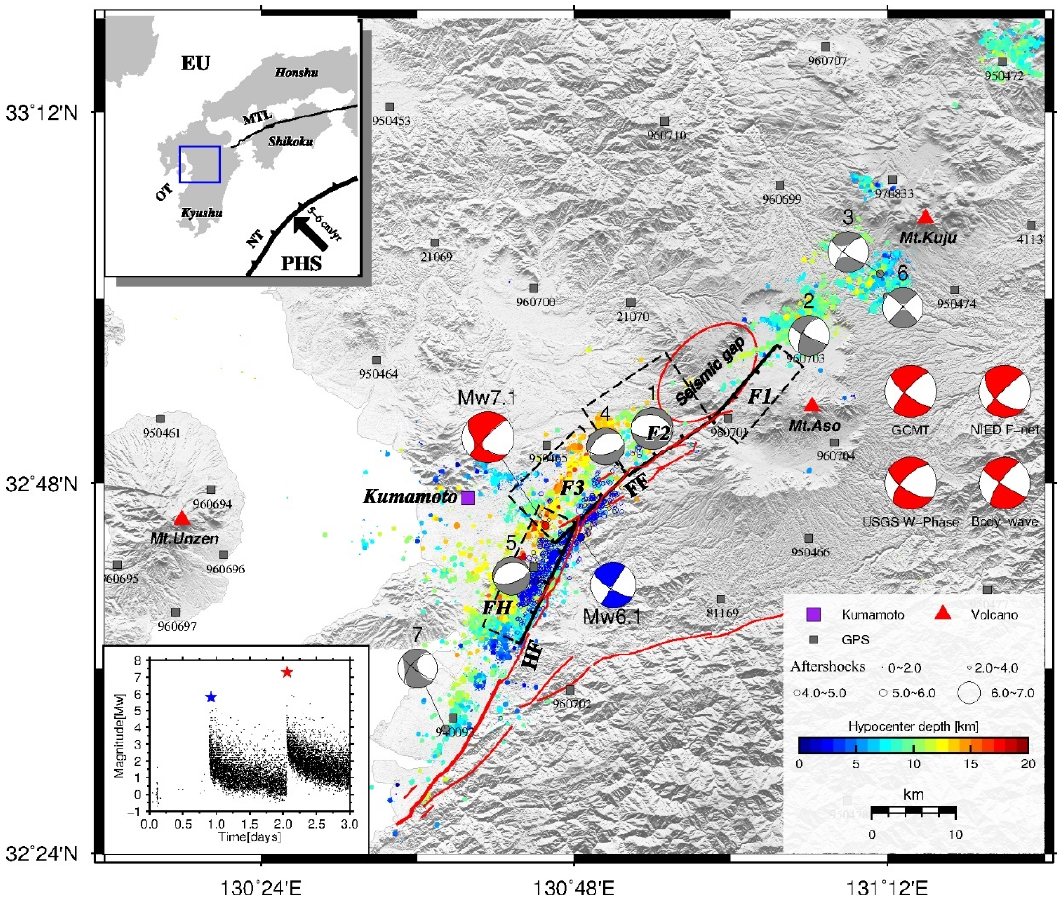
Figure 1. Tectonic setting of the 2016 Kumamoto earthquake, Kyushu island, in southwest Japan. The upper-left inset shows the seismogenic background of southwest Japan, while the blue rectangle delineates the study area. The lower-left inset illustrates the magnitude time evolution of the first three-day earthquake sequence, and blue and red stars denote the largest foreshock and mainshock, respectively. Blue and red beach balls indicate the focal mechanism solutions of the foreshock and mainshock determined by NIED F-net [6], respectively, while gray beach balls show aftershocks with Mw >5.0. Moreover, the mainshock focal mechanisms from other earthquake catalogs (e.g., GCMT [4], USGS [5] W-phase, and body wave) are also shown for comparison. Color-filled circles denote the relocated foreshocks (blue) and aftershocks (the filled color varies with hypocentral depth) until 30 April and the circles’ size is proportional to the magnitude [3]. The red ellipse illustrates a ~10 km-long seismic gap of aftershocks near the Aso volcano. Active faults are shown with red lines. The gray squares denote the GPS stations. The red triangles show the active volcanoes and the purple square is Kumamoto city. Surface projections of the assumed fault planes (marked as F1, F2, F3, and FH) are represented by black dashed rectangles (the top edge marked by thick lines). PHS, Philippine Sea Plate; NT, Nankai Trough; OT, Okinawa Trough; MTL, Median Tectonic Line; EU, Eurasian plate; FF, Futagawa fault; HF, Hinagu